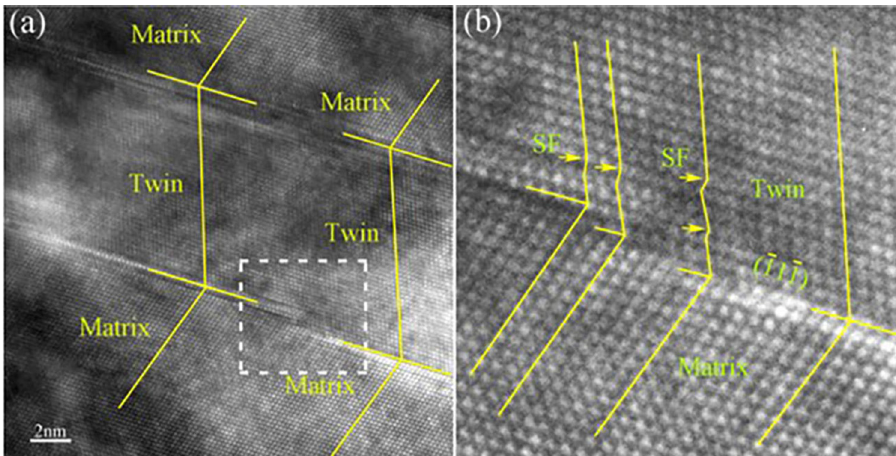
Figure 10: The HRTEM image of Al 0.3 CoCrFeNi, ( a ) a typical deformation twin and ( b ) the enlarged image of the white dashed square in ( a ) [ 121 ]